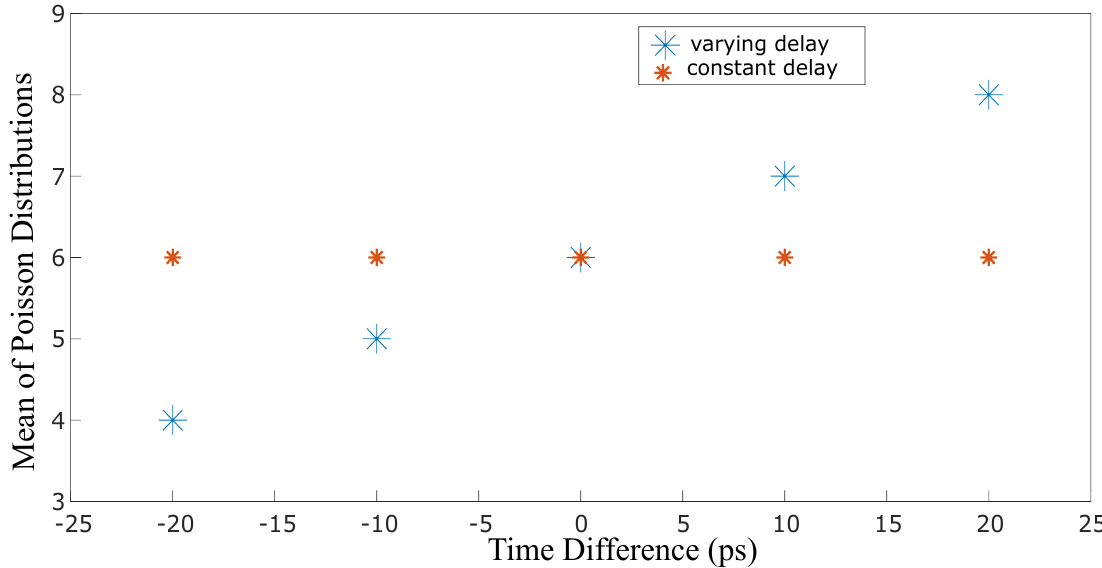
Figure 6. A graph of intensity vs time difference between the two pulses. One pulse hits the rising gradient at the same voltage value, thus having the same intensity each time (small fluctuations due to the quantum efficiency of the intensifier). The second pulse is moved by the translation stage, by 3 mm at a time, thereby arriving at different regions of the rising